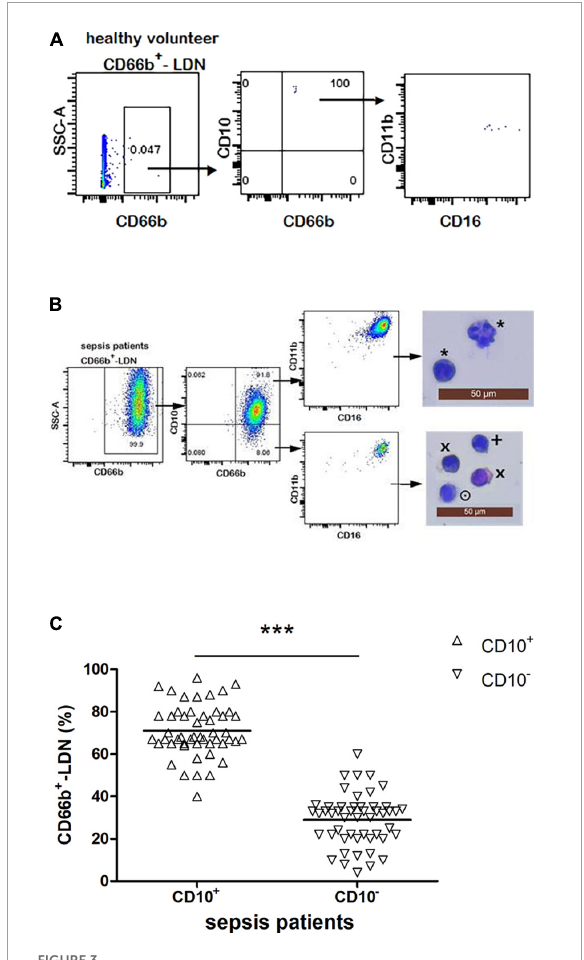
FIGURE3 (A) Flow cytometry chart of CD66b + CD10 + -LDN in healthy people. (B) Flow cytometry and cytological morphology of CD66b + CD10 + / − -LDN in sepsis patients. *Represents the mature neutrophils with a segmented nucleus typically characterized by of 2–5 lobes; × represents bend cell